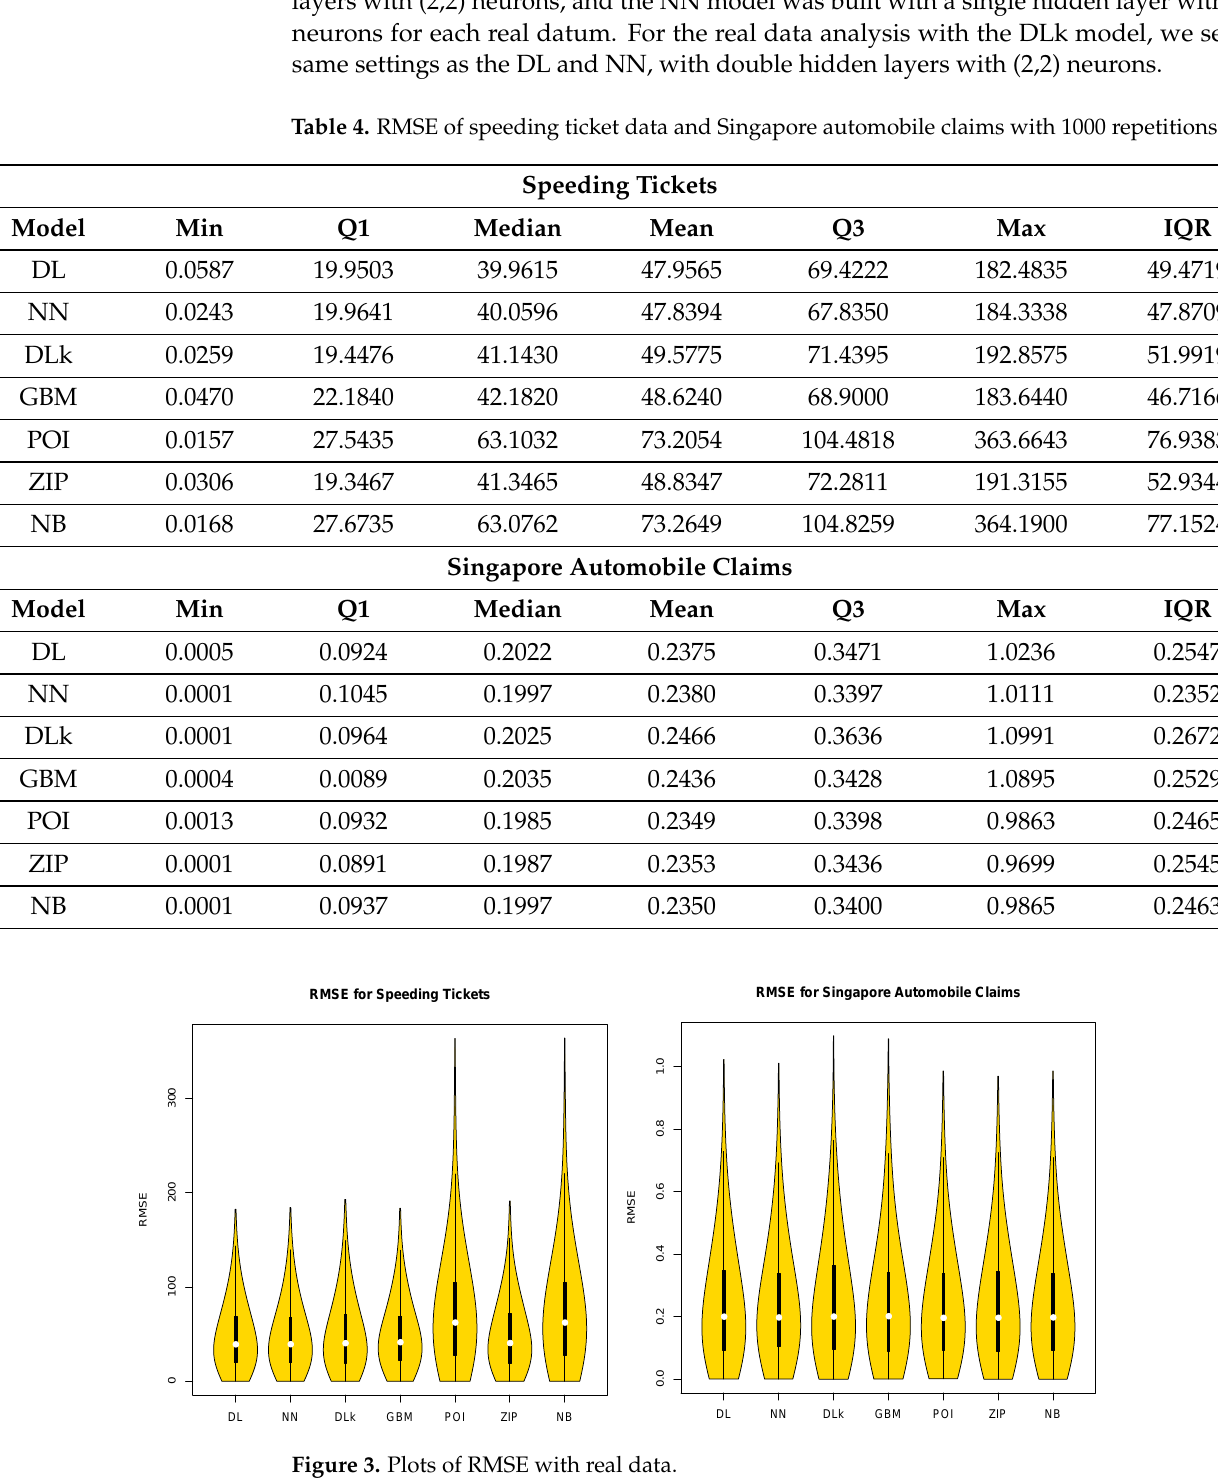
Figure 3. Plots of RMSE with real